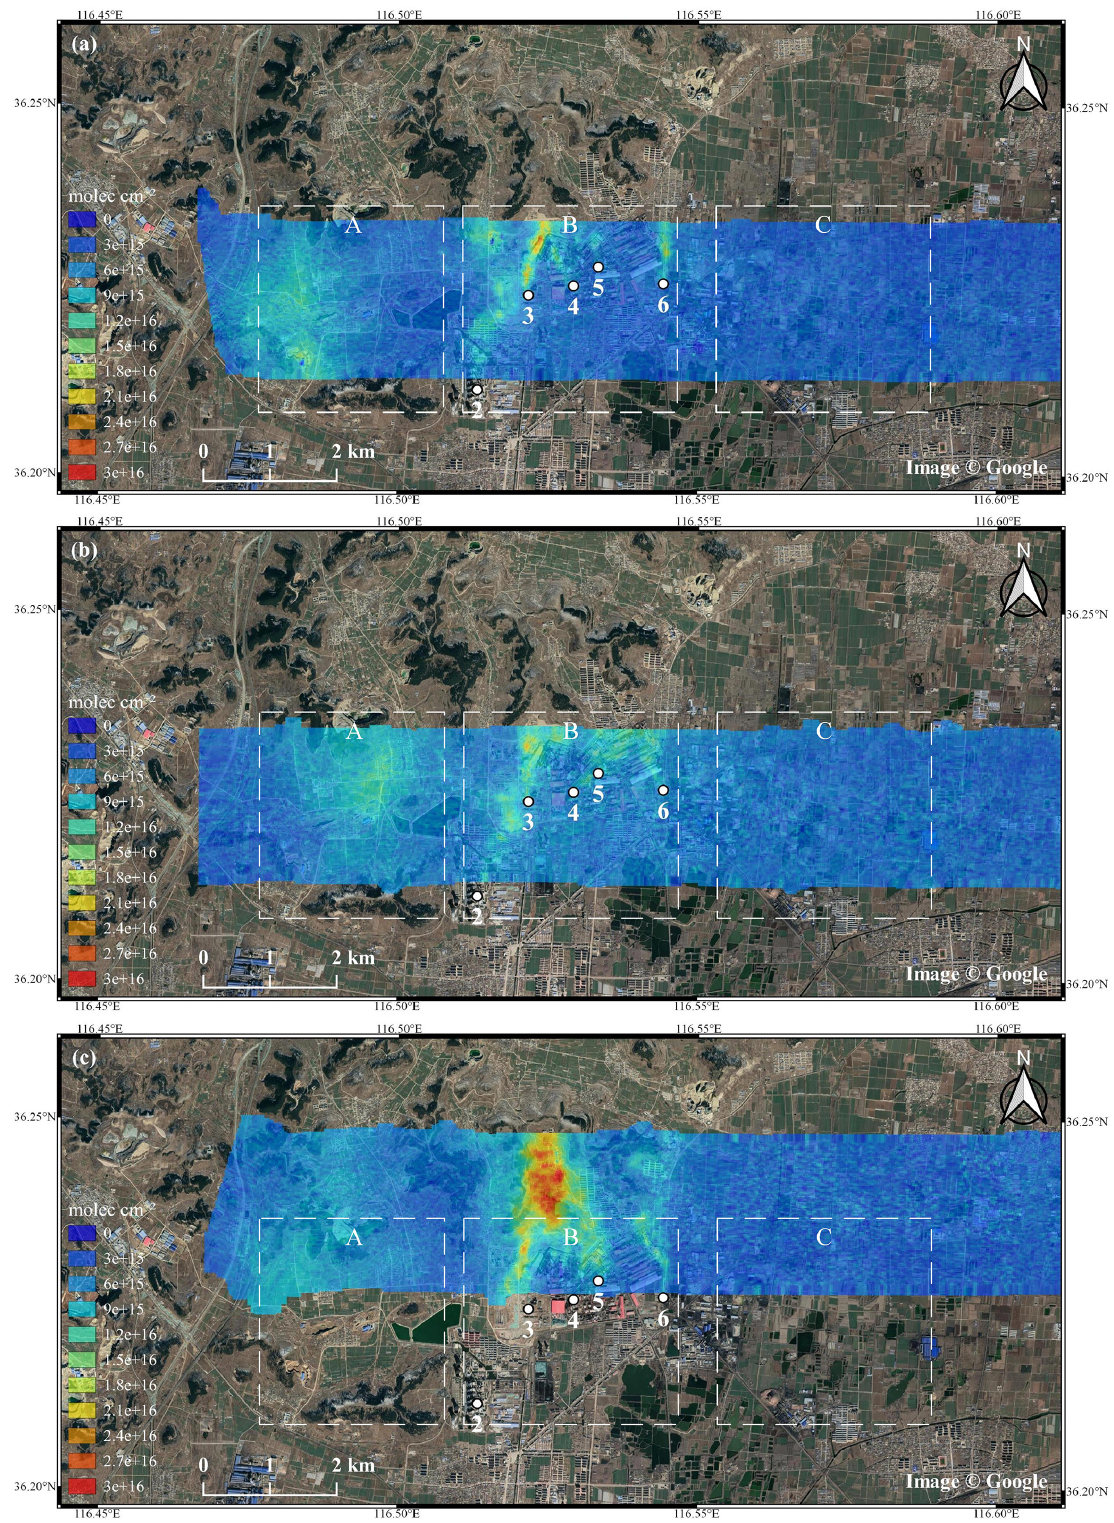
Figure 12. Three flight lines that pass through the steel factory at 13:26 (a) , 14:57 (b) and 13:32LT (c) . Panels (a) and (b) represent flight lines that cover the same area with a 1.5h time gap; (a) and (c) represent adjacent flight lines with a 6min time